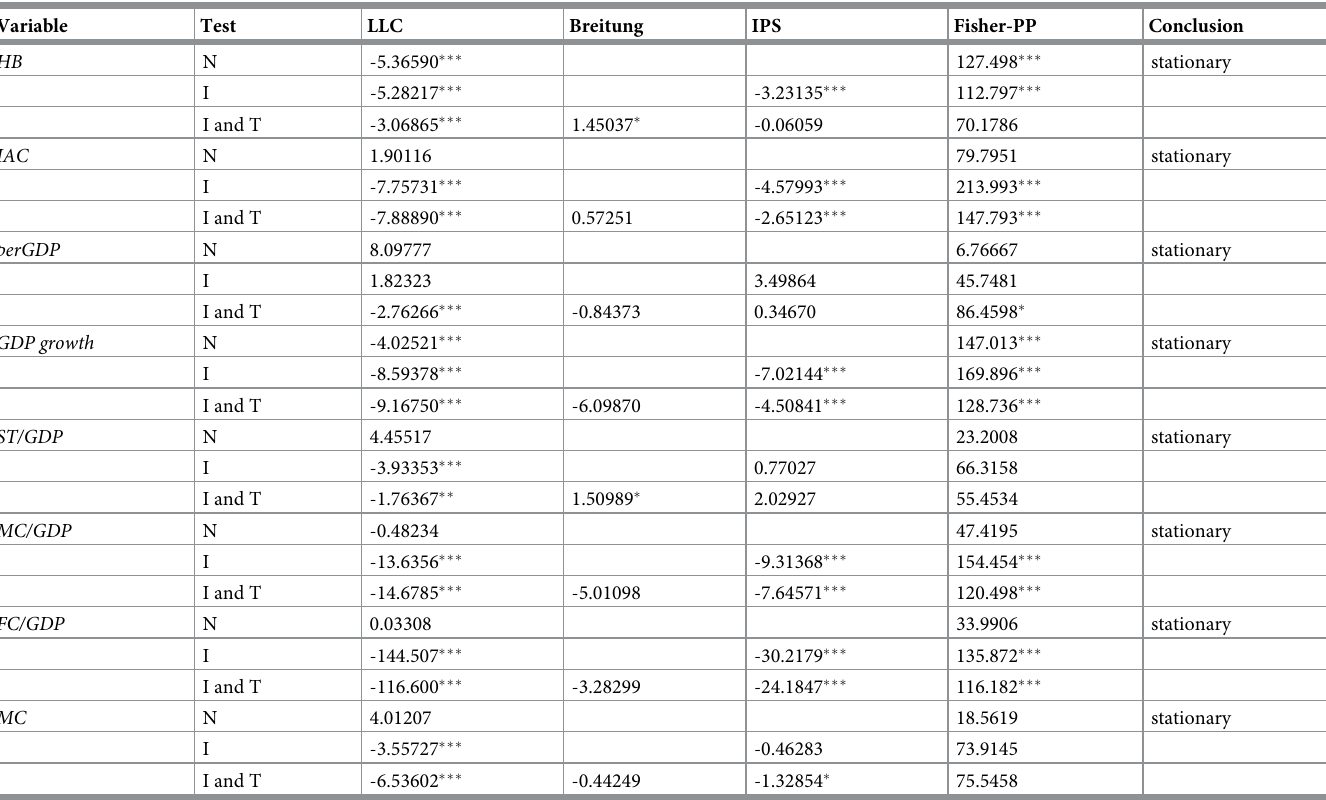
Table 3. The results of stationarity